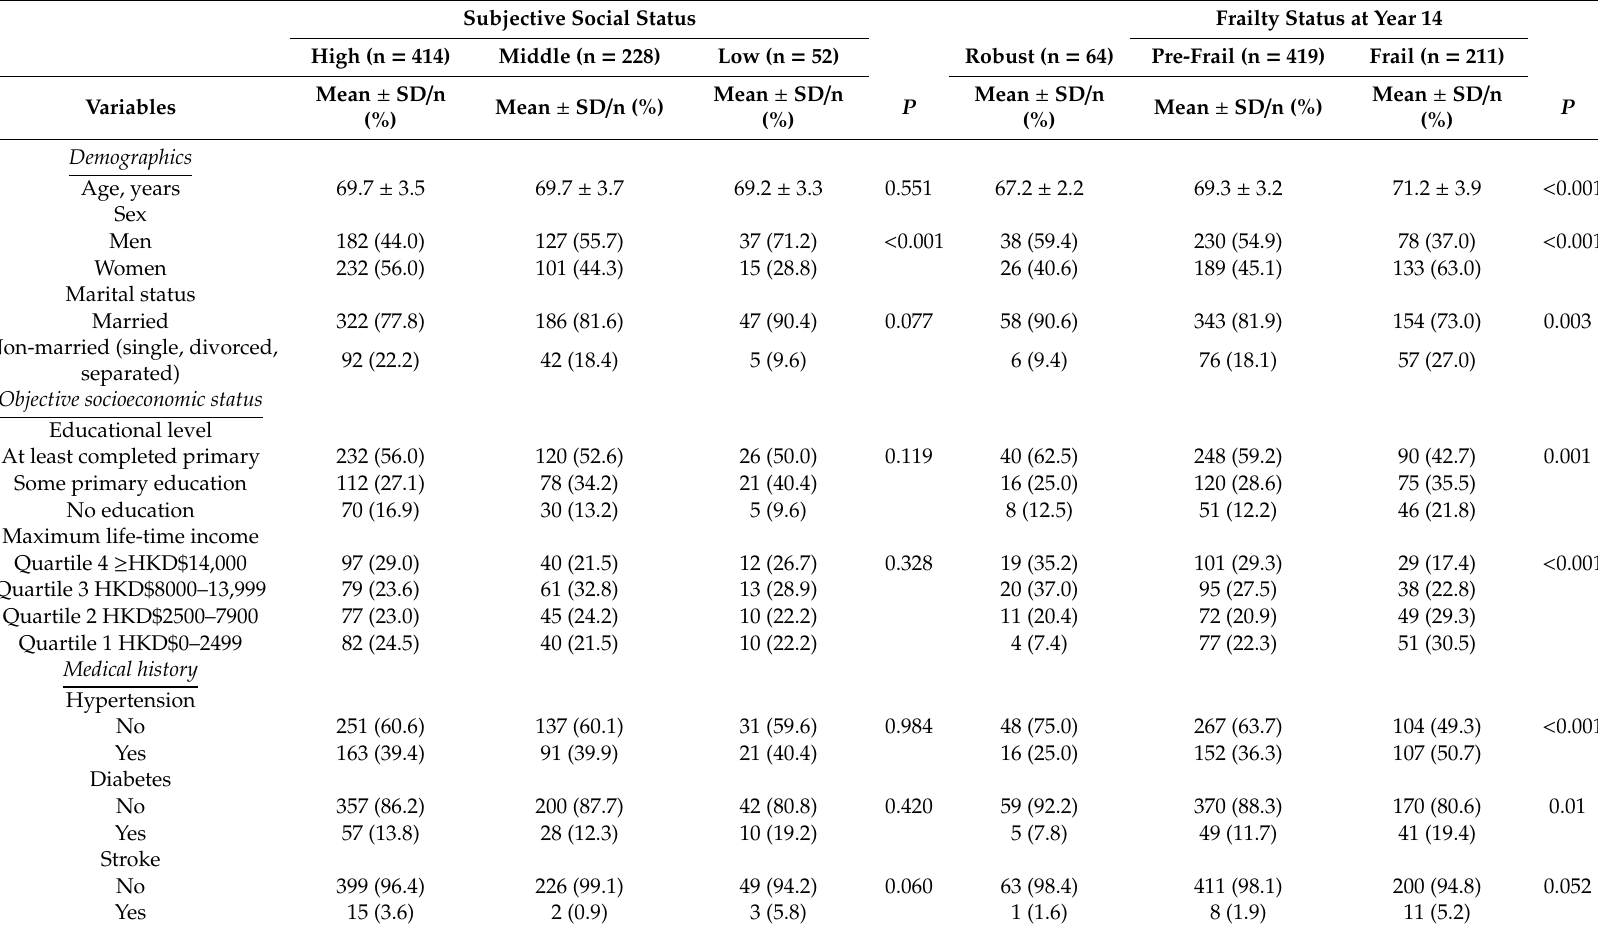
Table 1. Baseline characteristics of the study population according to subjective social status (community status ladder) at baseline and frailty status at 14-year follow-up (n =